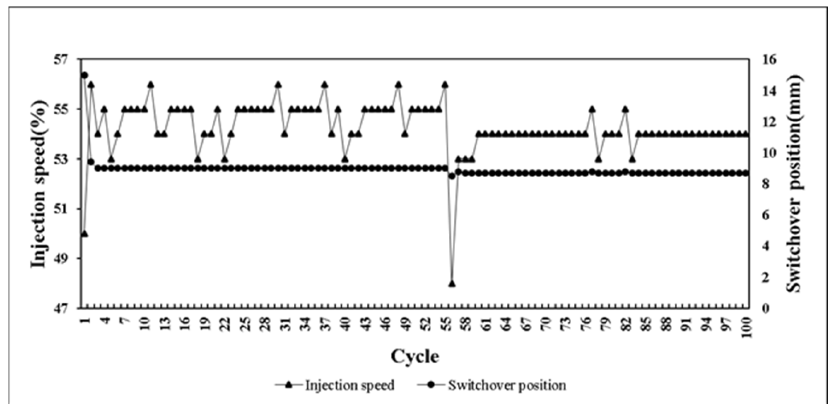
Figure 20. Adaptively adjust parameters results by adaptive control system.